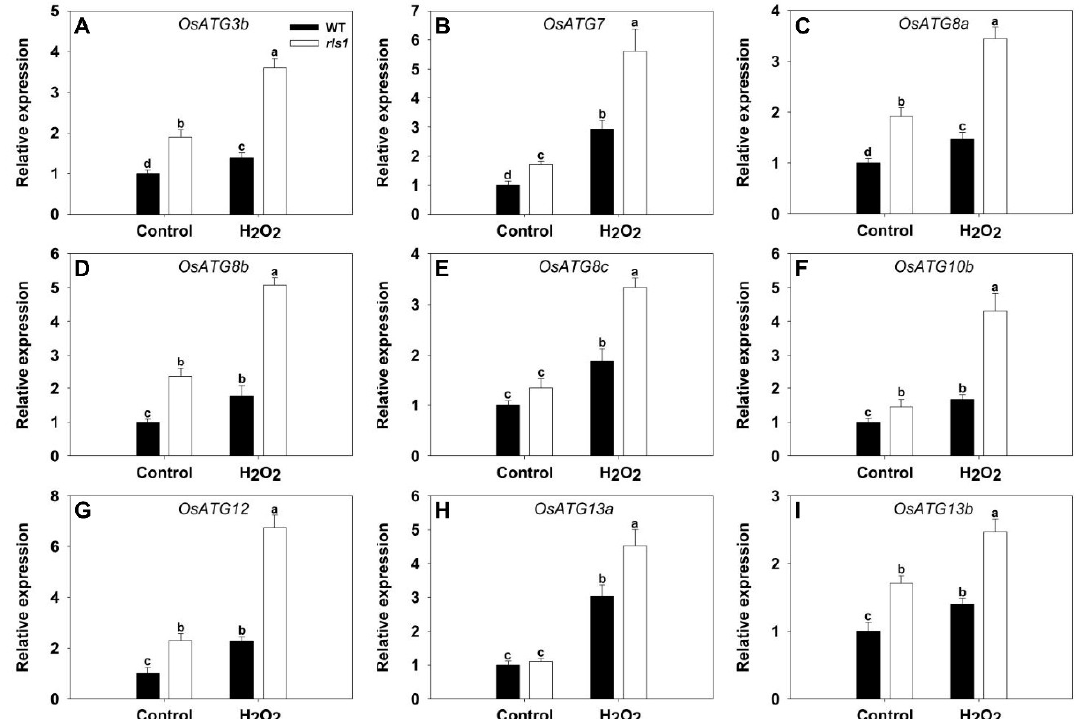
Figure 10. The transcriptional response of ATGs (autophagy-related genes) in WT and rls1 plants subjected to oxidative stress. ( A ) OsATG3b ; ( B ) OsATG7 ; ( C ) OsATG8a ; ( D ) OsATG8b ; ( E ) OsATG8c ; ( F ) OsATG10b ; ( G ) OsATG12 ; ( H ) OsATG13a ; ( I ) OsATG13b . For normalization purposes, the transcript abundance of each ATG in non-stressed WT was set to 1. Values expressed in the form mean ± SE ( n = 3). Significant differences between means ( p < 0.05) indicated by different letters.